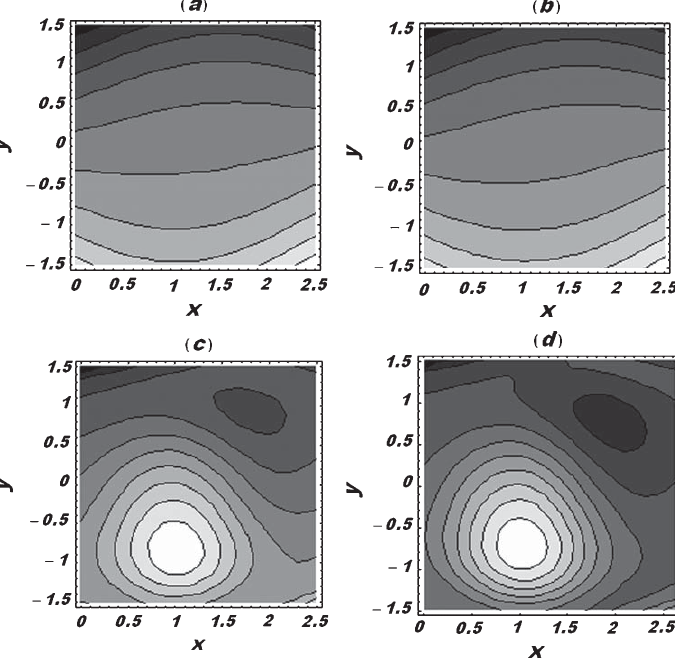
Fig. 22. Streamlines for a = 0 . 5, b = 0 . 7, d = 1, Re = 10, Fr = 1, β = 0 . 1, θ = 0 . 5, dp (2) /dx = 1 . 2, φ = π/ 6, (cid:15) = 0 . 01 with different sin α (a) sin α = 0, (b) sin α = 0 . 4, (c) sin α = 0 . 8, (d) sin α = 1 . 2.